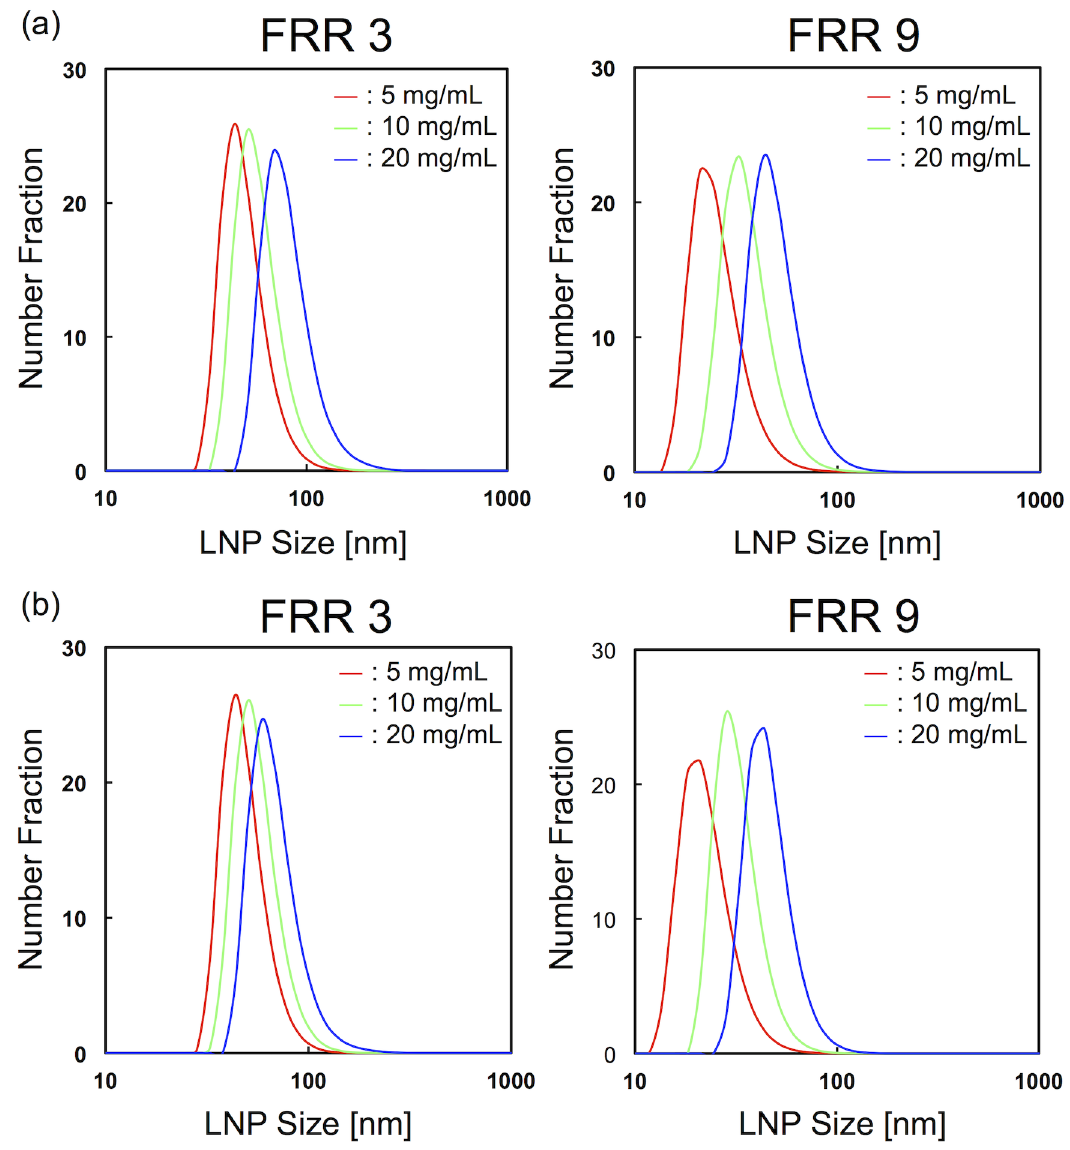
Fig 2. Size distributions of LNPs at FRR of 3 and 9 at different lipid concentration conditions. The flow rates were (a) 100 μ L/min and (b) 500 μ